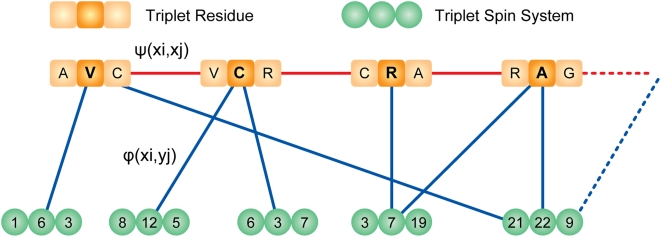
Graphical network for backbone chemical shift assignments.Overlapping tripeptides (triplet residue) are evaluated. The weights on the edges are derived from amino acid typing, secondary structures, connectivity experiments, and possible outlier assignments. According to the statistical physics model described in the text, application of the belief propagation algorithm yields the marginal probabilities for backbone assignments.